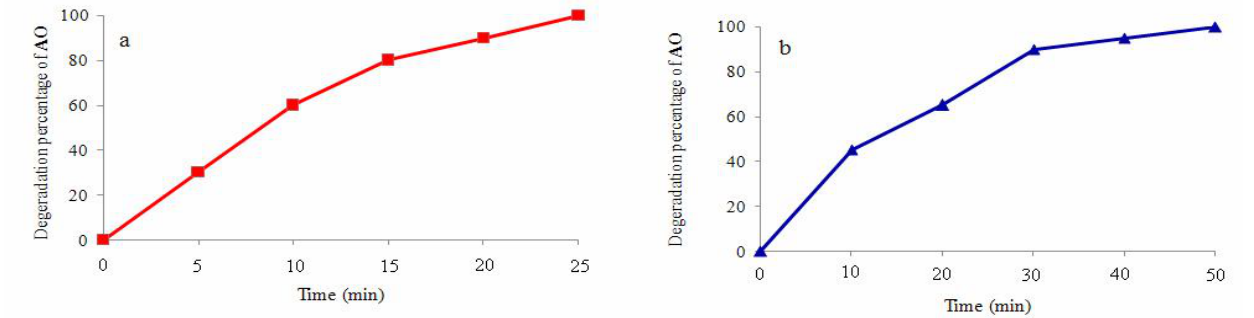
Fig. 8. Percentage degradation of AO with a) TiO 50 mg catalyst; 50 ml AO(10 mg l -1